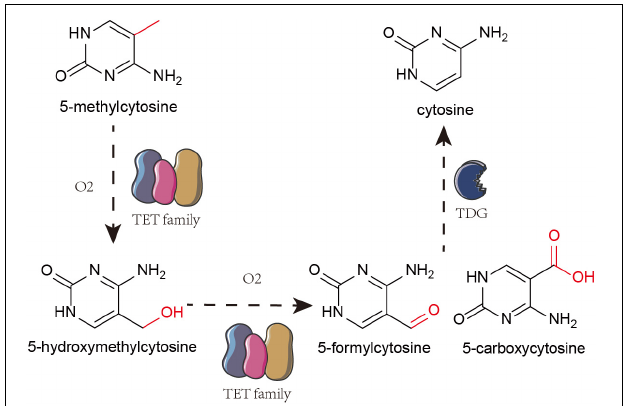
FIGURE 1 | Mechanism of DNA hydroxymethylation. TET family oxidize 5-mc to 5-hmC. And then, TET proteins further oxidize 5-hydroxymethylcytosine (5-hmC) into 5-formylcytosine and 5-carboxylcytosine. Finally, it removes the carboxyl group from 5-formylcytosine and 5-carboxylcytosine by TDG to restore them to unmethylated